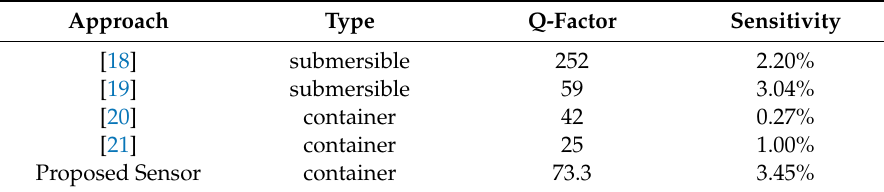
Table 3. Comparison of sensitivity.